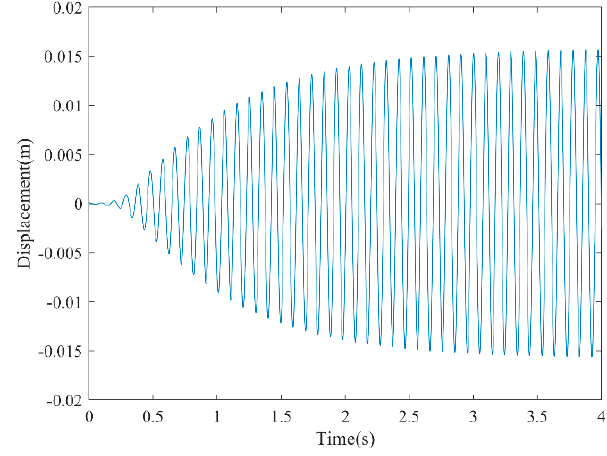
Figure 4. Time history displacement response ( U = 4.0 m/s).